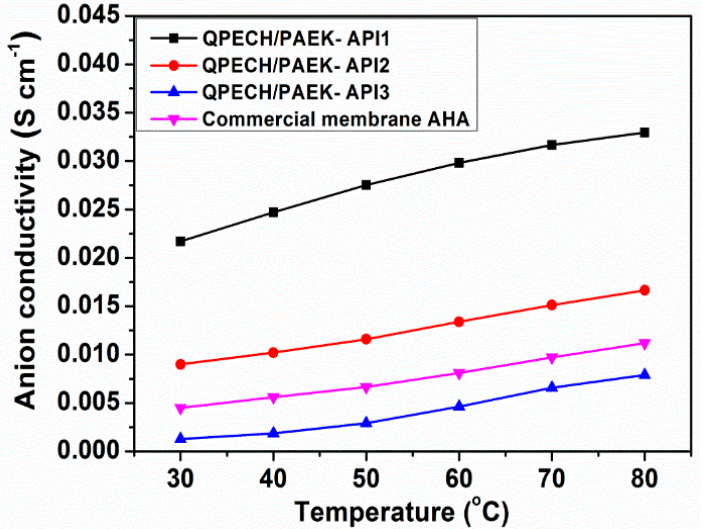
Figure 4. Temperature dependence of anion conductivity of QPECH/PAEK-API membranes.